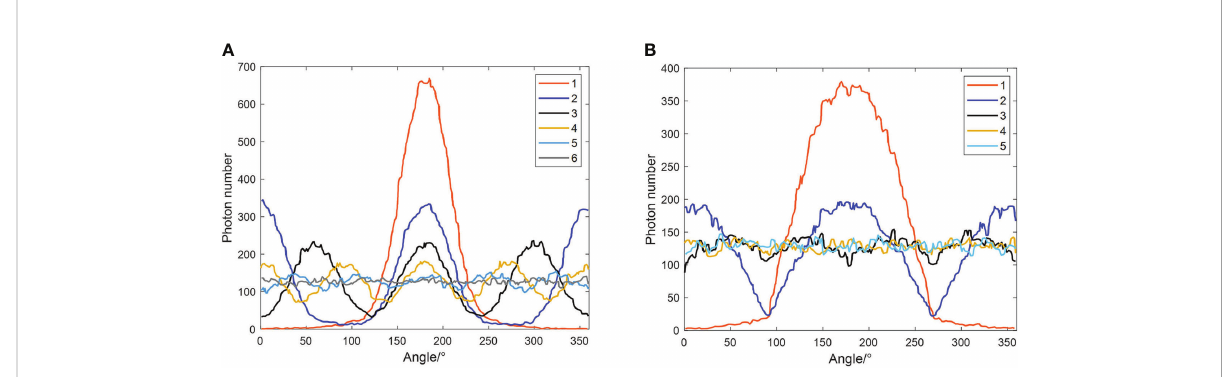
FIGURE 4 Photon distributions in the j direction of the LED array with half power angles of (A) 30° and (B)